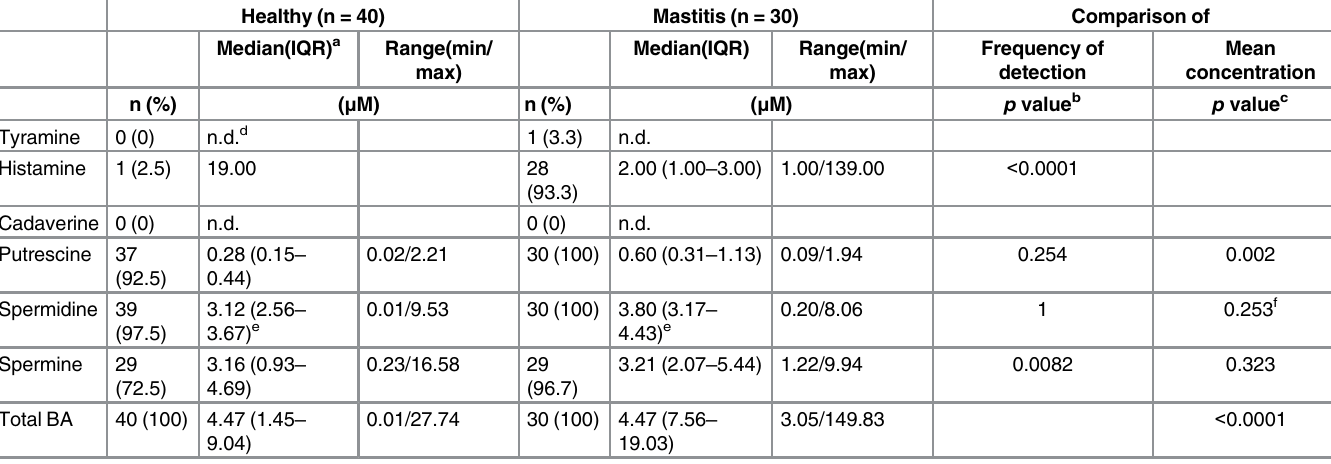
Table 1. Biogenic amine concentrations in milk of healthy and mastitis-suffering women quantified by UHPLC. Healthy (n = 40) Mastitis (n = 30) Comparison of Median(IQR) a Range(min/